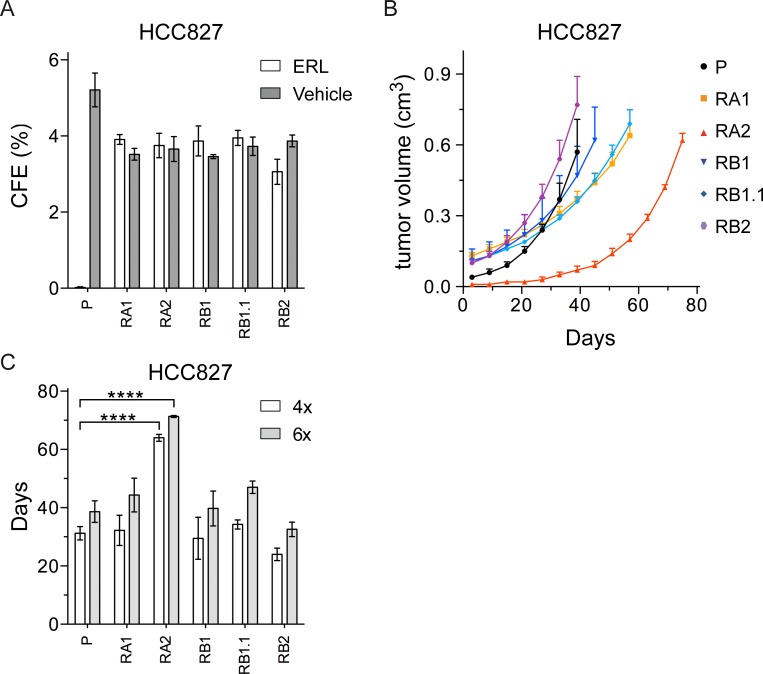
The ERL-resistant HCC827 cells lines are tumorigenic.A) Soft agar colonies were counted by ImageJ software. The percentage of colony forming efficiency (CFE) of parental (P) and ERL-resistant cell lines, as mean ± s.e.m., is shown. Histograms in gray and white colors indicate respectively vehicle (DMSO, 0.01%) and ERL (erlotinib 1 μM) cell treatments; B) Tumor volume of xenograft nodes, calculated as described in material and methods, are shown as mean ± s.e.m; C) Times to four (4x) and six fold (6x) increases from initial tumor volumes (day 3) are shown respectively by white and grey bars. P-values < 0.0001 are indicated.